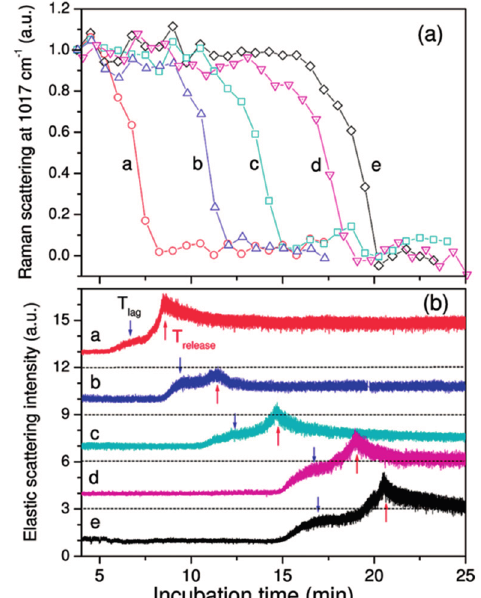
Figure 13. The Raman line ( a ) associated with the calcium dipicolinate biomarker is monitored during the spore germination process along with the intensity of elastic scattered light; ( b ) for varying particles. The individual particles show different germination times, indicated by the rapid decrease in the Raman scattering line at 1017 cm − 1 ( a ); but the germination process is consistently correlated with an increase in the elastic scattering of the cell ( b ) [61]. (With permission from ACS